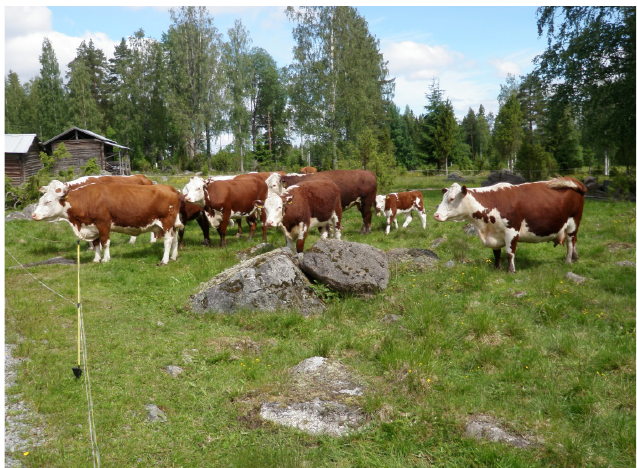
Figure 2: Pasturing modern cattle breeds on traditional rural biotopes has enabled the continuation of management. Especially farms with calver production have been interested in biodiversity and landscape management. Photo: Kaisa J.